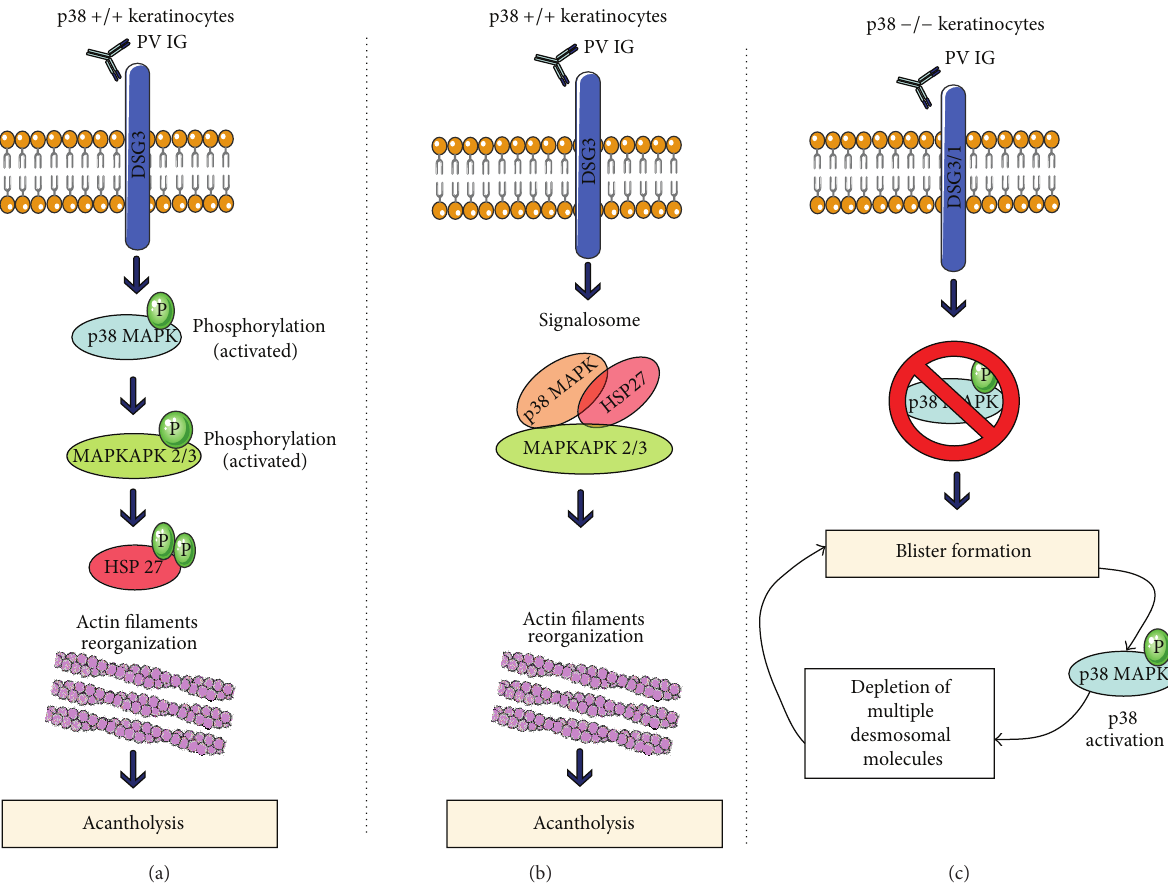
Figure 1: The role of p38 MAPK in the induction of pemphigus vulgaris (PV). There are at least three potential p38-MAPK-related mechanisms involved in the pathogenesis and/or the progression of PV. (a) The binding of pathogenic autoantibodies targeting Dsg3 in keratinocytes initiates an array of signals leading to the activation of p38 MAPK cascade with subsequent phosphorylation of MAPKAPK (mitogen-activated protein kinase-activated protein kinases 2/3) and heat shock protein 27 (Hsp 27). The final outcome of these events is actin filaments reorganization and induction of acantholysis [19]; (b) p38 MAPK, MAPKAPK, and Hsp27 may form a complex (signalosome) that regulates the reorganization of actin filaments and the induction of acantholysis [20]; (c) studies in p38 − / − keratinocytes demonstrate a p38 MAPK-independent blister formation. The subsequent activation of this pathway, however, can lead to de novo depletion of multiple desmosomal molecules, further facilitating spontaneous blister formation [21]. This latter hypothesis indicates that p38 MAPK signaling may not be responsible for the induction of PV but could play a role for the progression of the